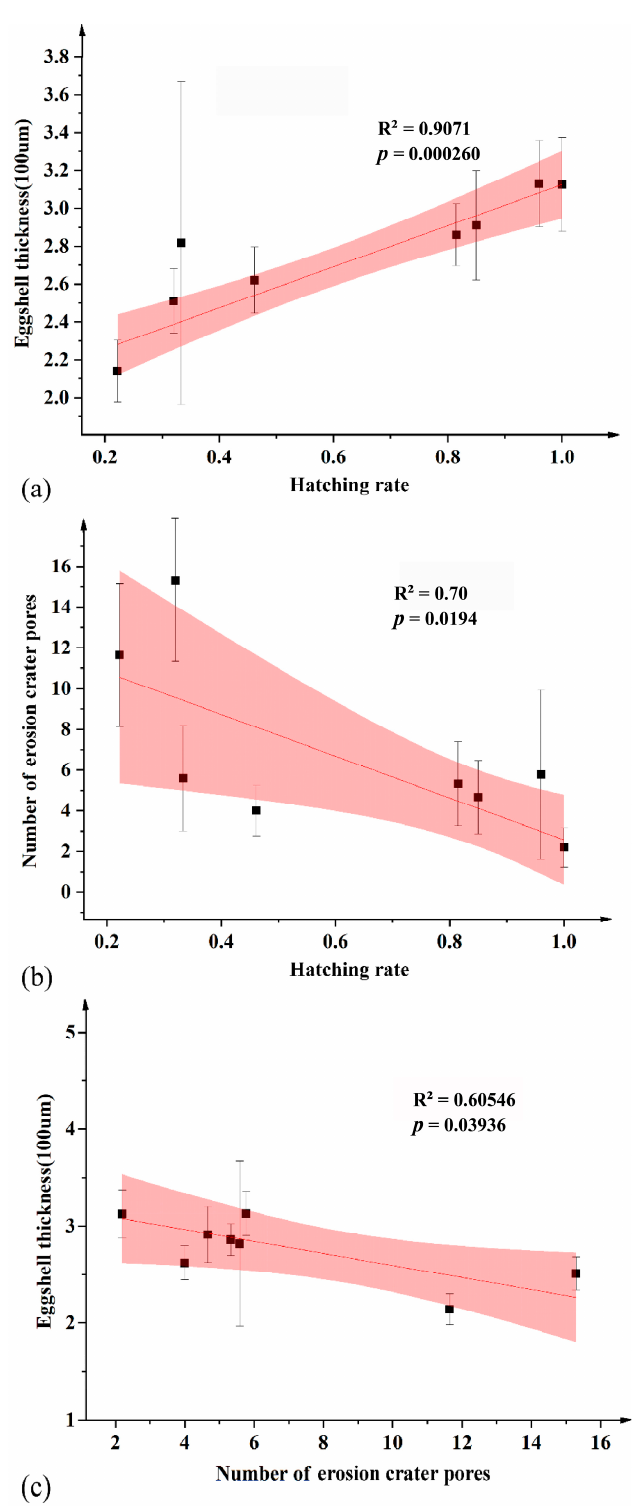
Figure 3. Eggshell thickness and hatching rate showed a significant positive correlation ( p < 0.05) ( a ). The number of erosion-crater pores on the eggshell surfaces showed a significant negative correlation with the hatching rate ( p < 0.05) ( b ). Eggshell thickness and the number of erosion-crater pores were significantly negatively correlated ( p < 0.05) ( c ).